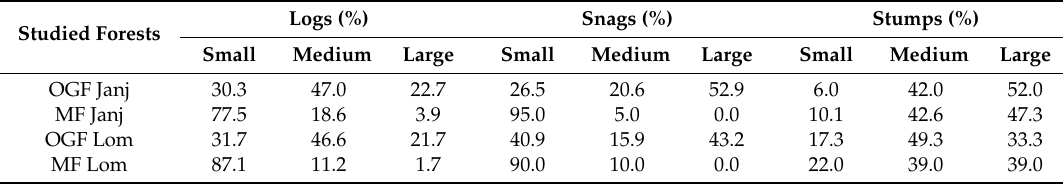
Table 4. Percentage of small (7.5–27.5 cm diameters), medium-sized (27.6–50.0 cm diameters), and large (diameters > 50.0 cm) logs, snags, and stumps in old-growth forests (OGFs) and managed forests (MFs) in Janj and